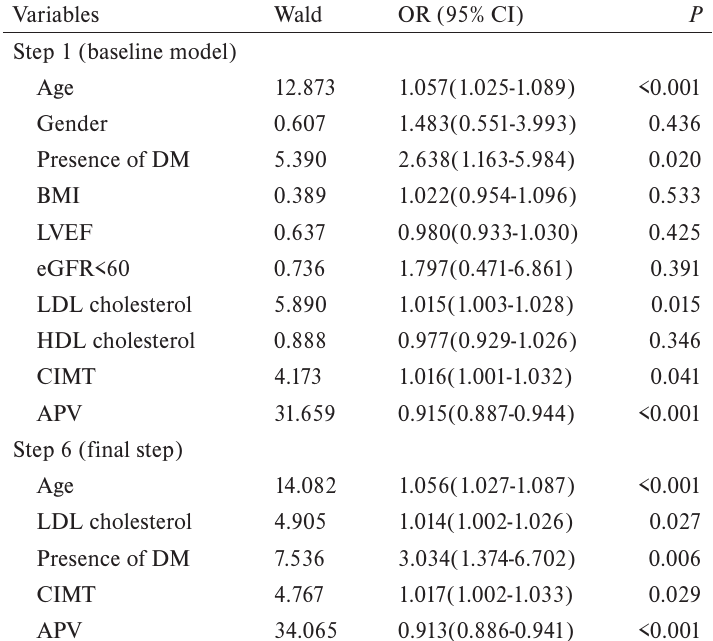
Table 2. Predictors of high SS.